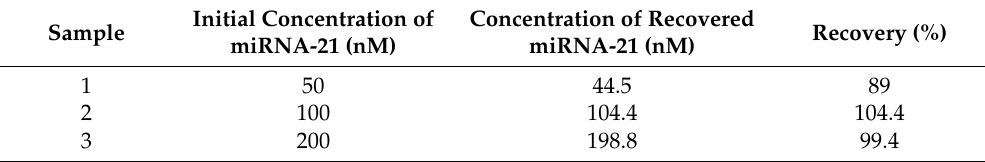
Table 1. Recovery of miRNA in diluted human serum using the proposed